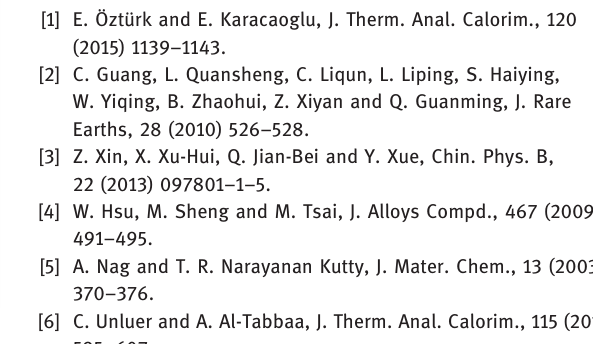
Figure 9: The PL spectra of Mg 3 SiO 5 : Eu 3+ , Dy 3+ system